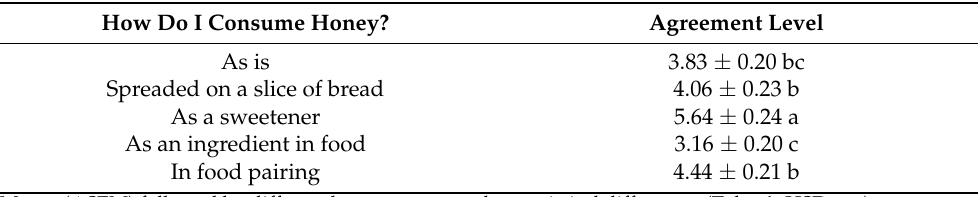
Table 8. Preferred honey consumption mode scored on a 9-point scale (1 = disagree completely; 9 = agree completely).